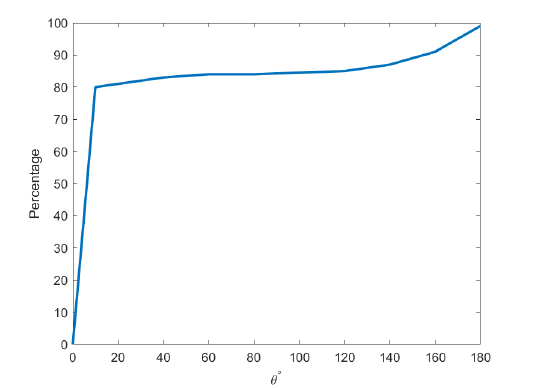
Figure 5. Cumulative histogram of absolute differences between estimated and reference angles. The abscissa gives the absolute value of the angle difference in